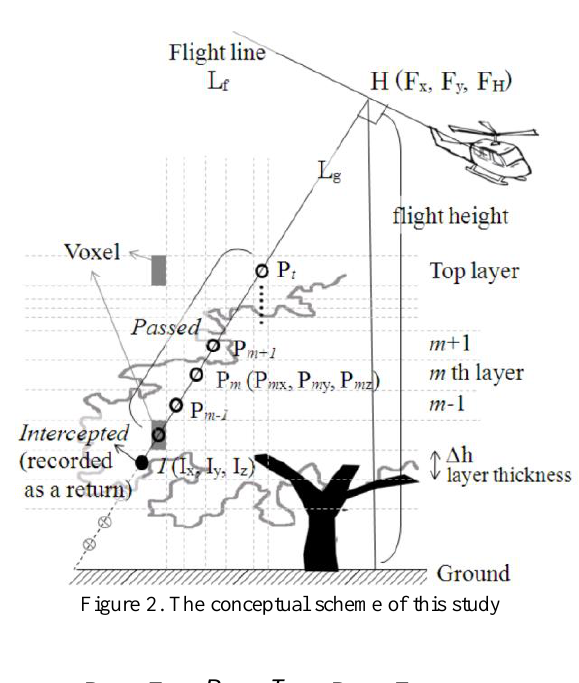
Figure 2. The conceptual scheme of this